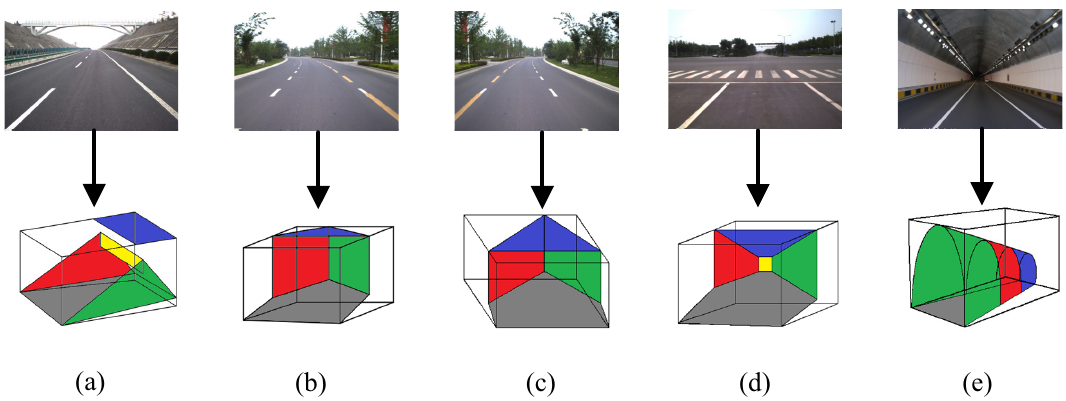
Figure 5. Scene stages of traffic scenes. ( a ) through lane; ( b ) left-turn lane; ( c ) right-turn lane; ( d ) intersection; ( e )